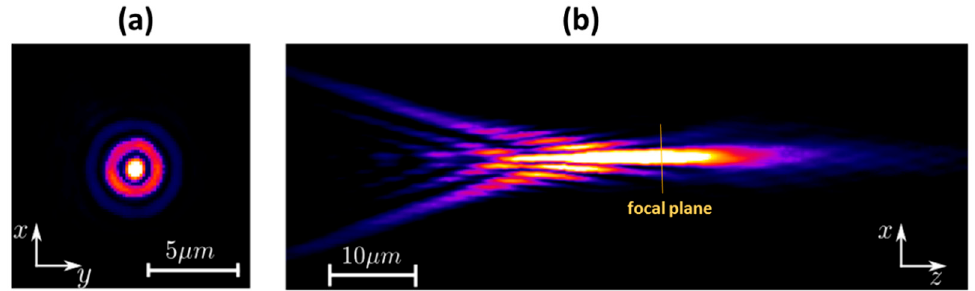
Figure 6. Measured Intensity Point Spread Function (IPSF) of micro ball lens (500-µm diameter), measurement in transmission at NA = 0.45: ( a ) image of the focal plane (XY slice) that was obtained at the focal plane; and, ( b ) XZ slice of IPSF along the optical axis.